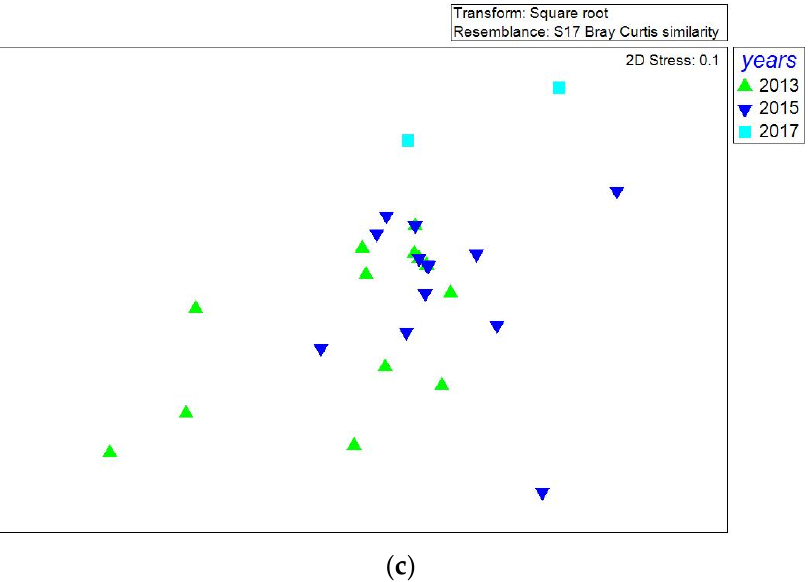
Figure 11. Representation of non-parametric multidimensional scaling (nMDS) of Southern Adriatic Sea samples (Dinophyta and Ciliophora genera considered) collected in 2013, 2015, and 2017, including ( a ) epipelagic and mesopelagic samples together, ( b ) only epipelagic samples and ( c ) only mesopelagic samples. For MD (maximum depth) samples, only those at more than 200 m below the sea level, have been considered.